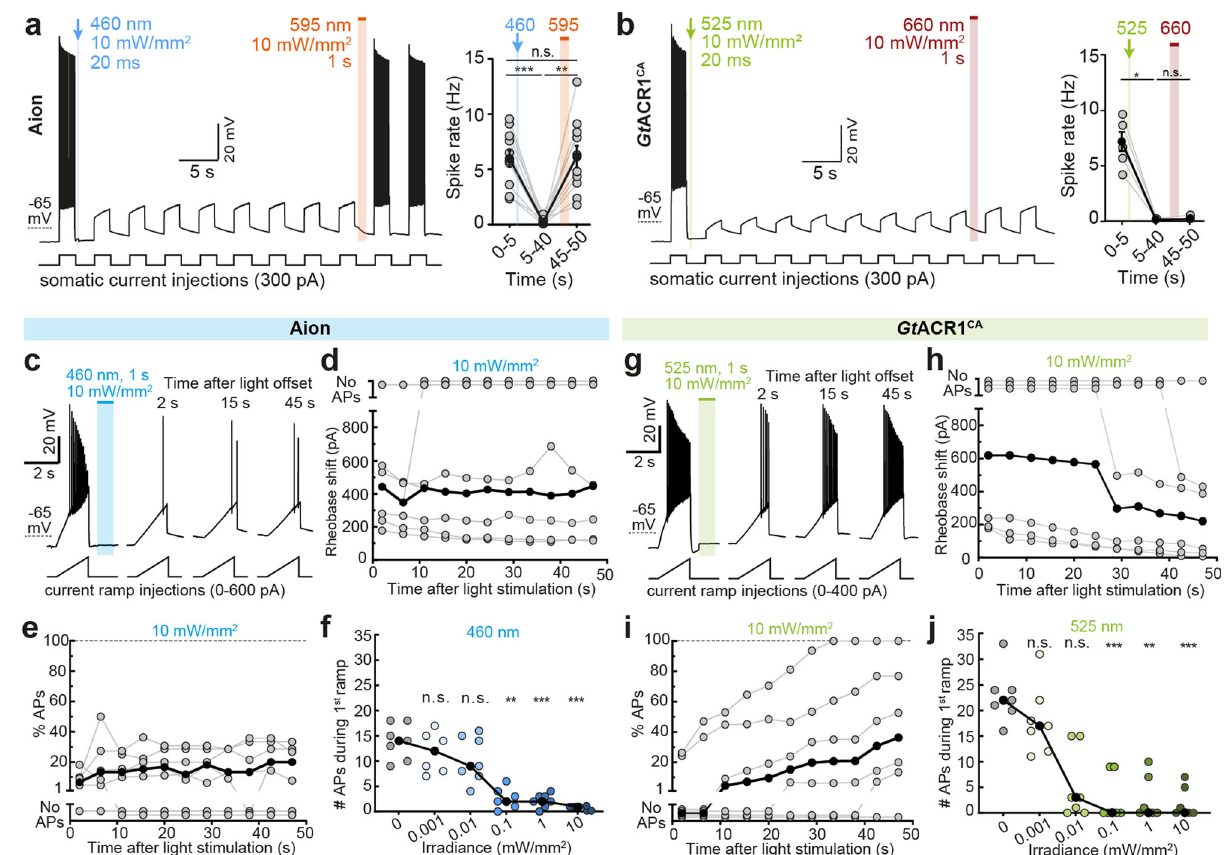
Fig. 3 Silencing ef fi ciency of Aion and Gt ACR1 CA in CA1 pyramidal neurons. a Membrane voltage trace showing reversible suppression of depolarization- induced action potentials (APs) by photoswitching Aion between open and closed state with a blue (460 nm, 20 ms, 10 mW/mm 2 ) and an orange light pulse (595 nm, 1 s, 10 mW/mm 2 ), respectively. Right: Quanti fi cation of spike rate during current injection at indicated time intervals: before channel opening (0 – 5 s), after channel opening (5 – 40 s), and after channel closing (45 – 50 s) in Aion-expressing CA1 neurons ( n = 10 cells). b Same as ( a ) but for neurons expressing Gt ACR1 CA ( n = 5 cells). The channel was opened with a green (525 nm, 20 ms, 10 mW/mm 2 ) light pulse. Note that in Gt ACR1 CA - expressing cells AP fi ring could not be recovered immediately after illumination with red light (660 nm,1 s, 10 mW/mm 2 ). c Current ramps were injected into Aion-expressing neurons to induce APs before and after illumination with a short blue light pulse (460 nm, 1 s, irradiances from 0.001 to 10 mW/ mm 2 ). For each ramp, the injected current at the time of the fi rst AP was de fi ned as the rheobase. Example membrane voltage traces are shown for the trial in which a light intensity of 10 mW/mm 2 was used. d Quanti fi cation of the rheobase shift and ( e ) the relative change in the number of current ramp- evoked APs over 47 s after light stimulation (460 nm, 1 s, 10 mW/mm 2 ) ( n = 7 cells). f Number of APs evoked during the fi rst current ramp after opening of Aion with 1 s blue light at indicated irradiances. Signi fi cant AP block was achieved at 0.1 mW/mm 2 ( n = 7 cells). g – j Same experiment as shown in ( c – f ) except that CA1 neurons expressed Gt ACR1 CA ( n = 6 cells in h , i and 7 cells in j ) and 525 nm-light was used for channel opening. Note that Gt ACR1 CA silencing ef fi cacy decayed already within the fi rst minute after light stimulation ( i , j ). For ( a , b , d – f , and h – j ) fi lled circles represent single measurement data points and black circles correspond to medians, Friedman test, * p < 0.05, ** p < 0.01, *** p < 0.001, n.s. not signi fi